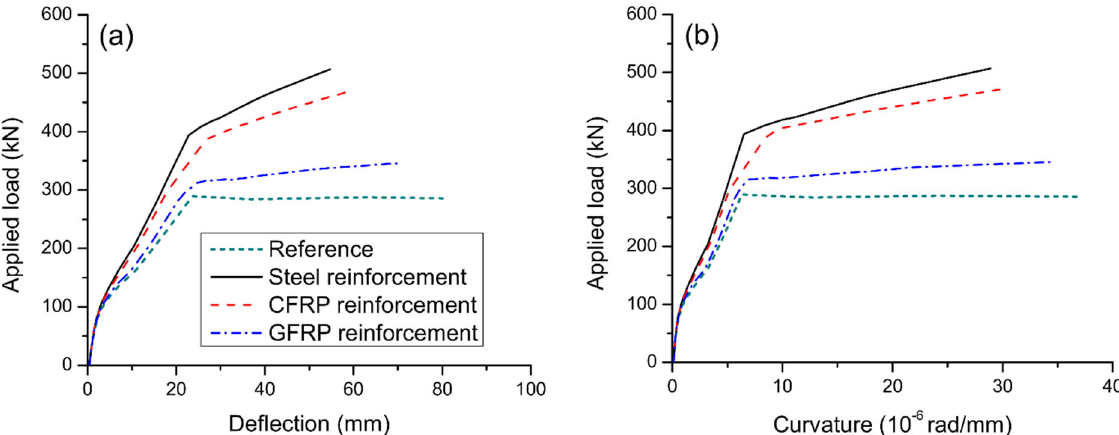
Figure 6. Effect of reinforcement type on the deformation at midspan. ( a ) deflection development; ( b ) curvature development.